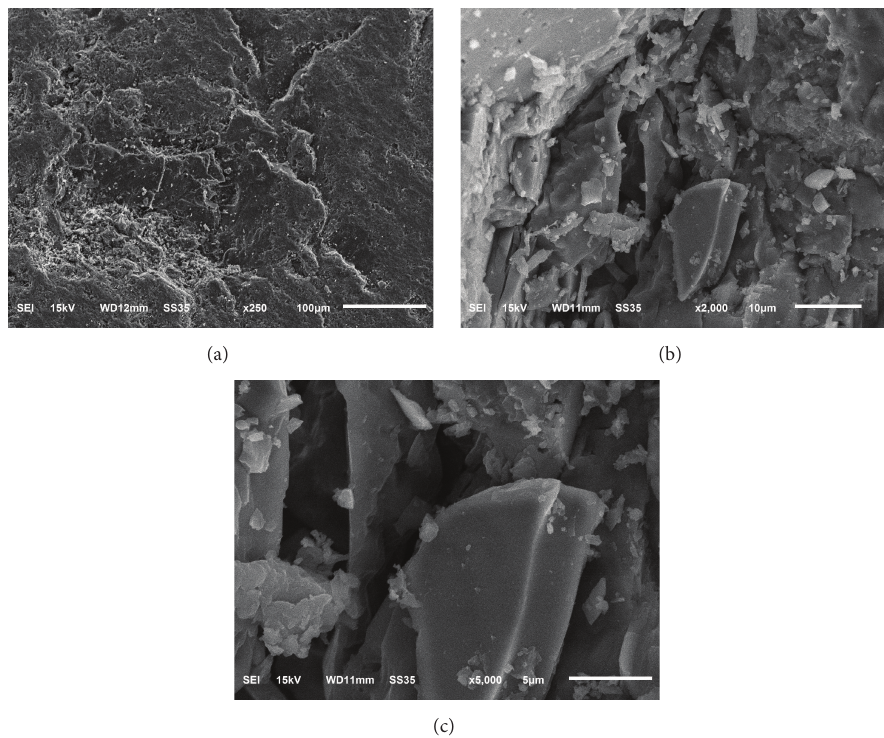
Figure 1: SEM photomicrographs of granite gneiss: (a) enlarged 250 times; (b) enlarged 2000 times; (c) enlarged 5000 times.